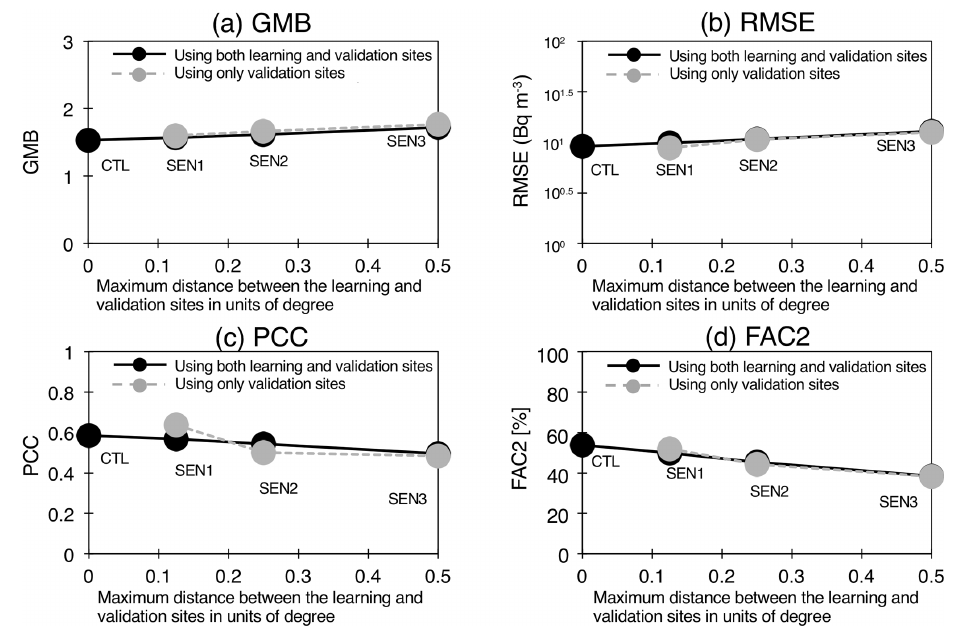
Figure 6. Statistical metrics (GMB, RMSE, PCC and FAC2) at the available sites for CTL, SEN1, SEN2 and SEN3. The statistical metrics are calculated using all sites (in black) and the independent sites (in grey), which are not used in the LMVE ensemble method. The names of the experiments are shown in each panel. The x axis represents a maximum distance between the learning and validation sites in units of